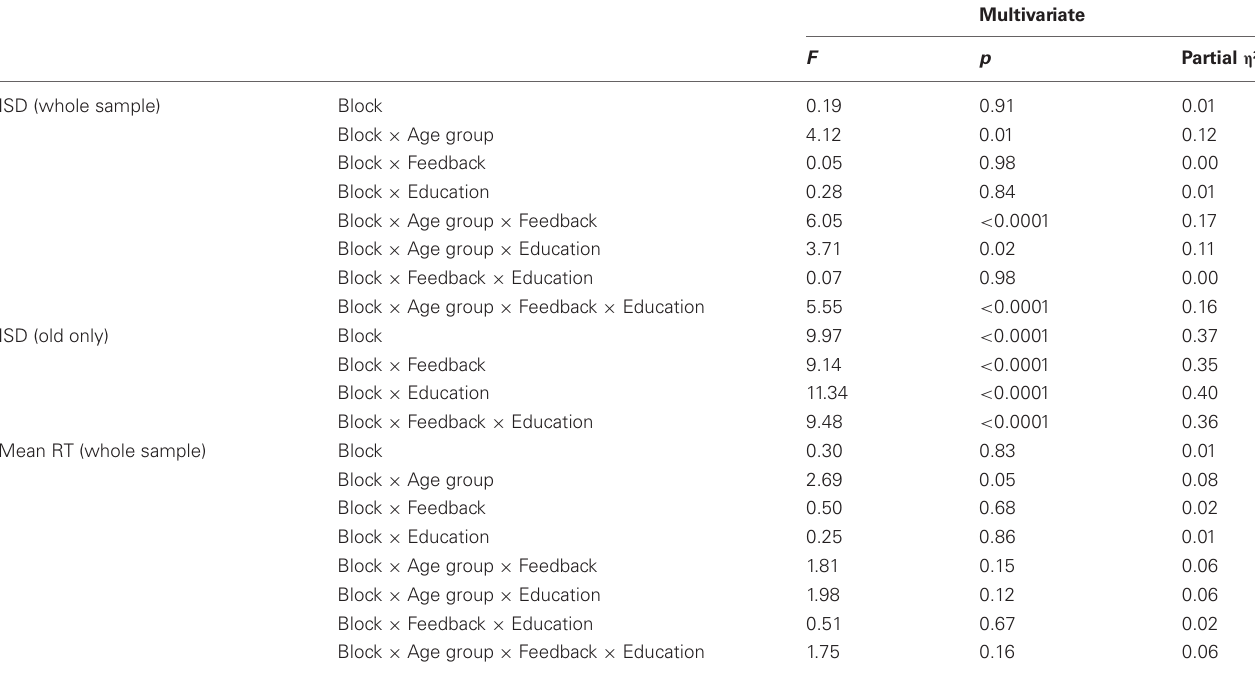
Table 1 | Repeated-measures model results of ISD- and mean RT-based analyses.